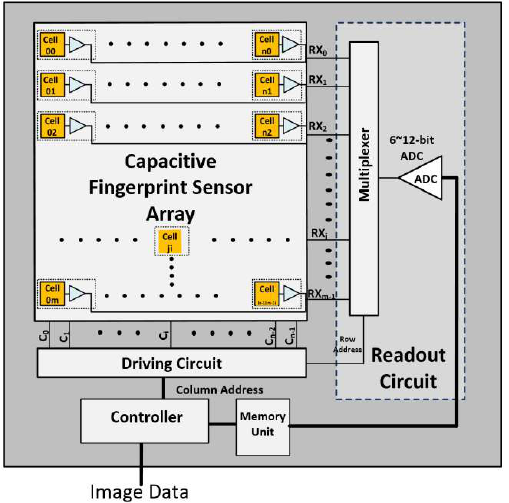
Figure 2. Block diagram of conventional sequential fingerprint sensing architecture.